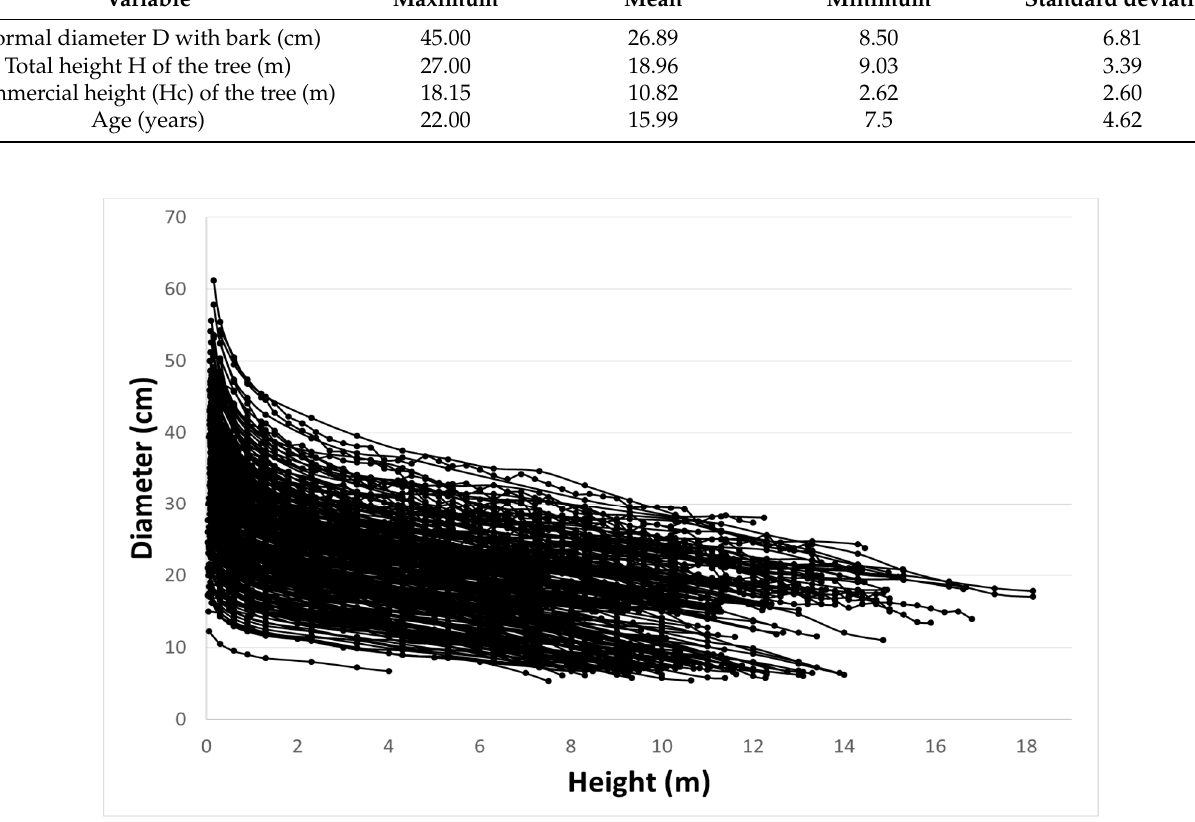
Figure 2. Diameter behavior of T. grandis trees in the